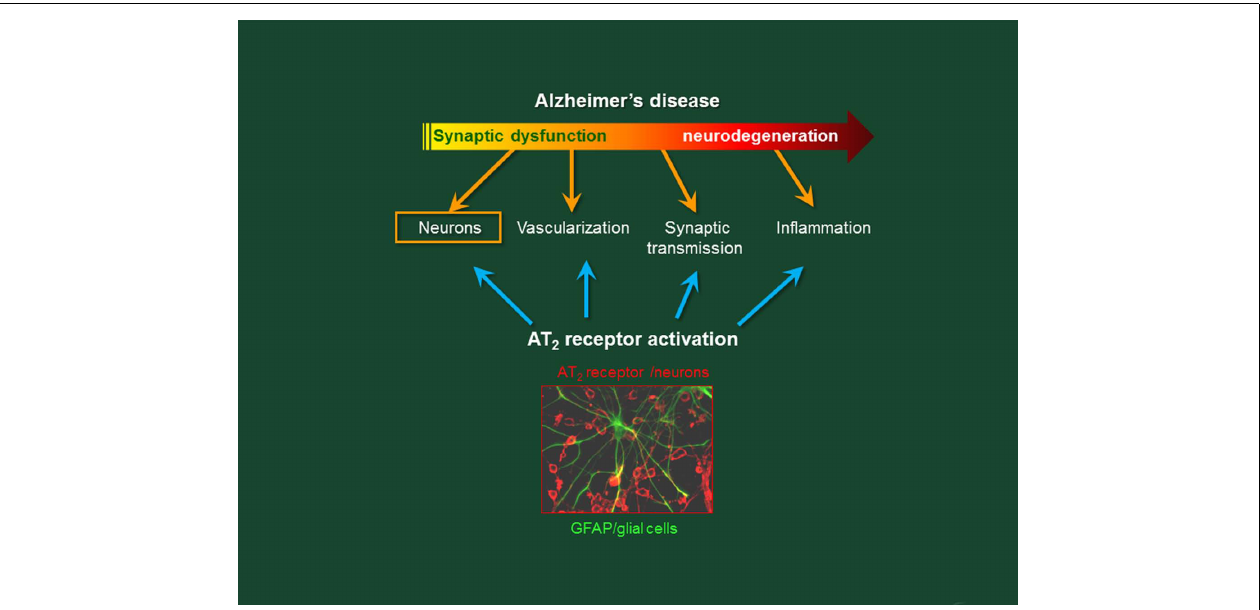
FIGURE 2 |Alzheimer’s disease: targets of functional disruptions and proposed protective functions associated with the activation of theAT2 receptor of angiotensin